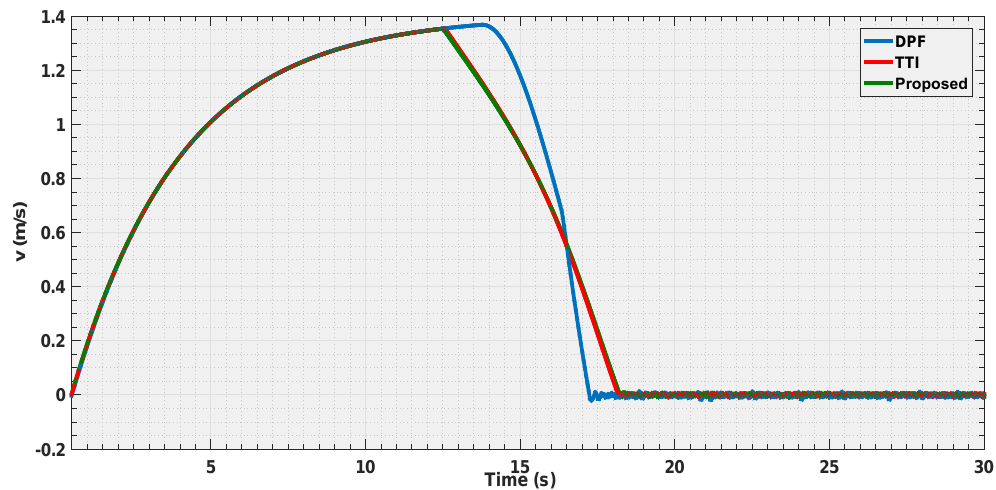
Figure 16. Velocity estimation by the three evaluated algorithms Experiment 2